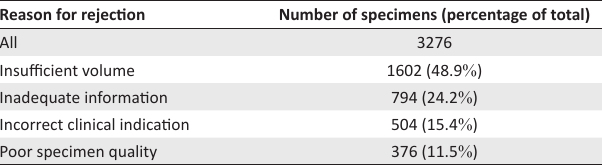
TABLE 2: Dried blood spots rejected because of pre-analytical problems in 2014 at the Department of Virology laboratory at Inkosi Albert Luthuli Central Hospital, KwaZulu-Natal province, South Africa. Reason for rejection Number of specimens (percentage of